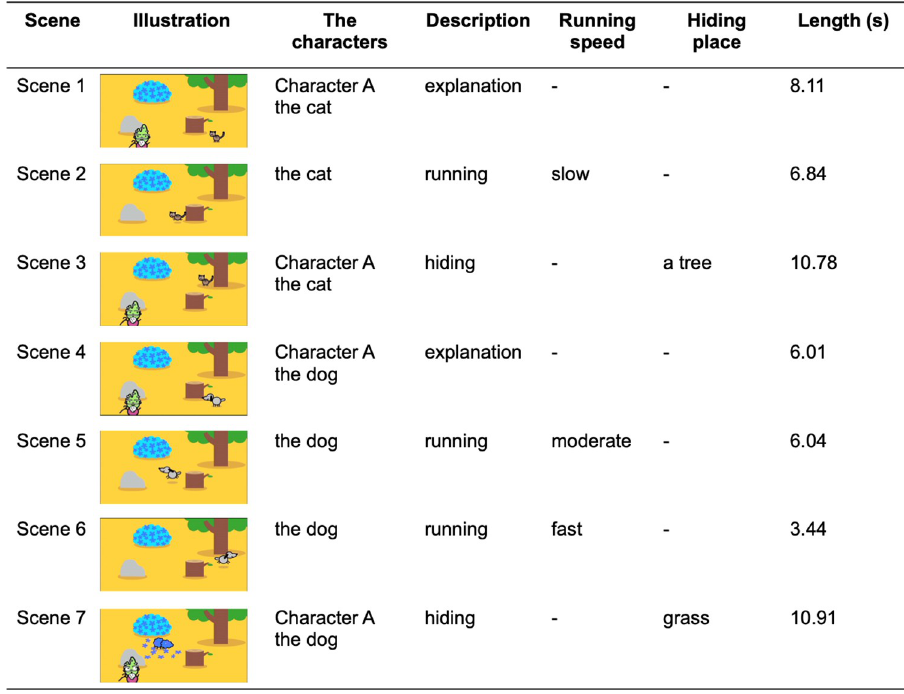
Fig 1. Video contents used in this study. The video consisted of seven scenes. Scenes were categorized based on the character’s motion: explanation, running, and hiding in a tree or grass. The characters’ running speed in running scenes was divided into three paces; slow, moderate, and fast. The illustration in each scene was an exemplified frame. https://doi.org/10.1371/journal.pone.0265623.g001 primary process of calculating the saliency score is computing a saliency map using an image processing algorithm. We used spectral residual (SR) [17] and fine grained (FG) [18] for still images, and motion (Mo) [19] saliency maps for the video (Fig 2). SR was displayed by subtracting the average logarithmic spectrum value from the value transformed from each image using the inverse Fourier transform method. FG emphasized main border lines for essential parts of the object using an integral image. Mo detected objects using background subtraction algorithms that selected useful backgrounds at different times. Using these saliency maps, the saliency score was computed as the following process: